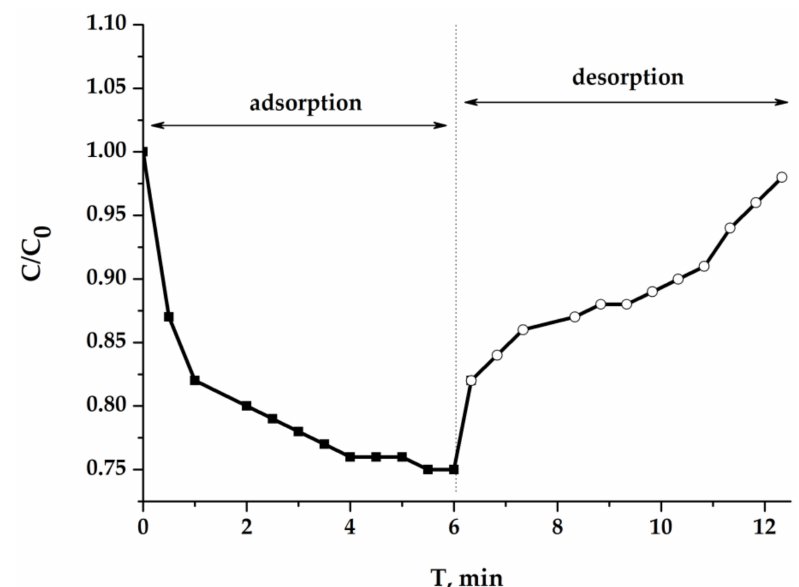
Figure 10. NaCl concentration depending on time in batch process: C 0 = 1.0 g / dm 3 (0.017 eqv / dm 3 ); U = 1.2 V; porous electrode (cm): 3 × 3 × 0.5; electrode gap: 1 cm.